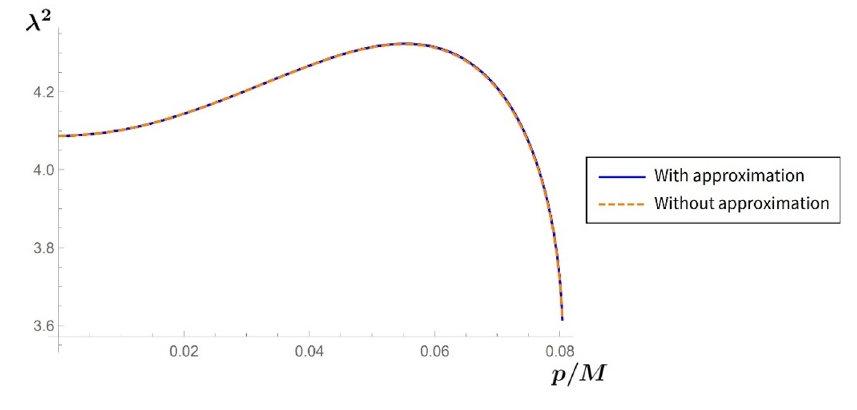
Figure 2 . Plot of λ 2 of radial perturbations against p/M